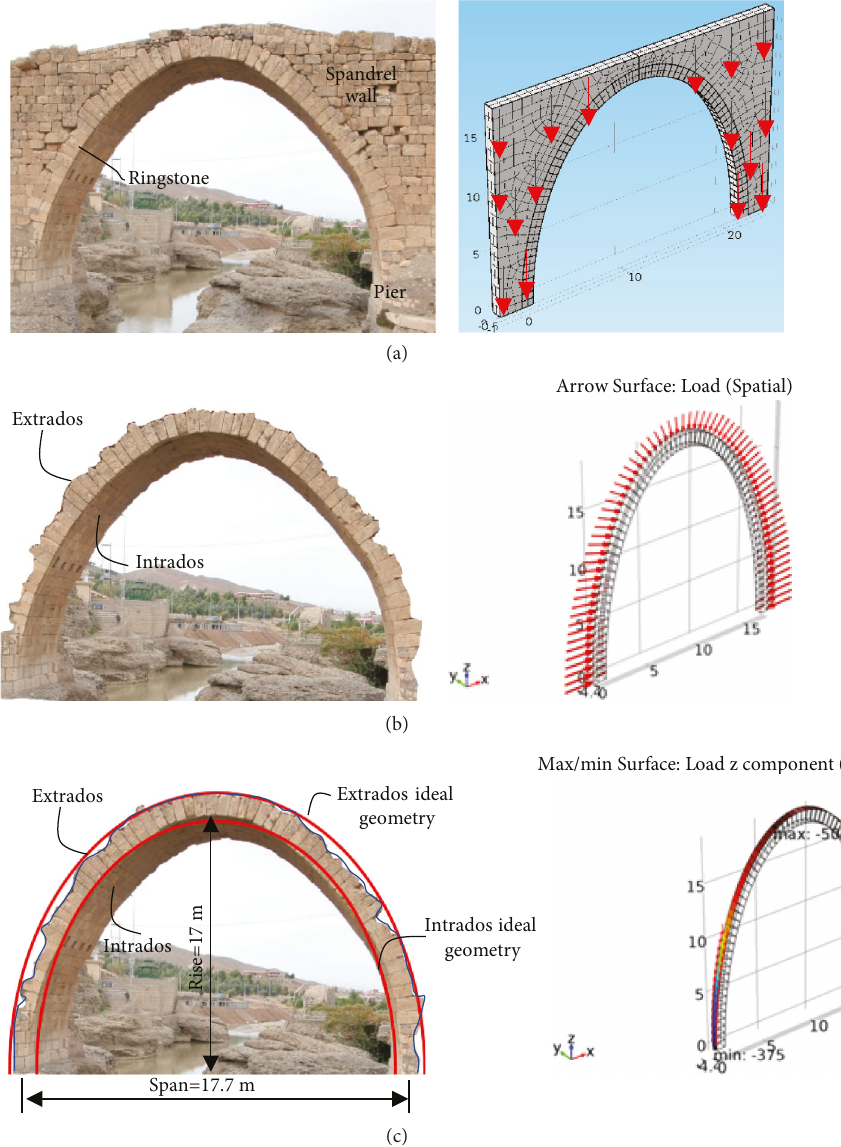
Figure 2: Three models of the arch’s ringstone: (a) arch and spandrel wall under self-weight; (b) ringstone subjected to a boundary surface load in the local coordinate system; (c) ringstone under a z -axis directed